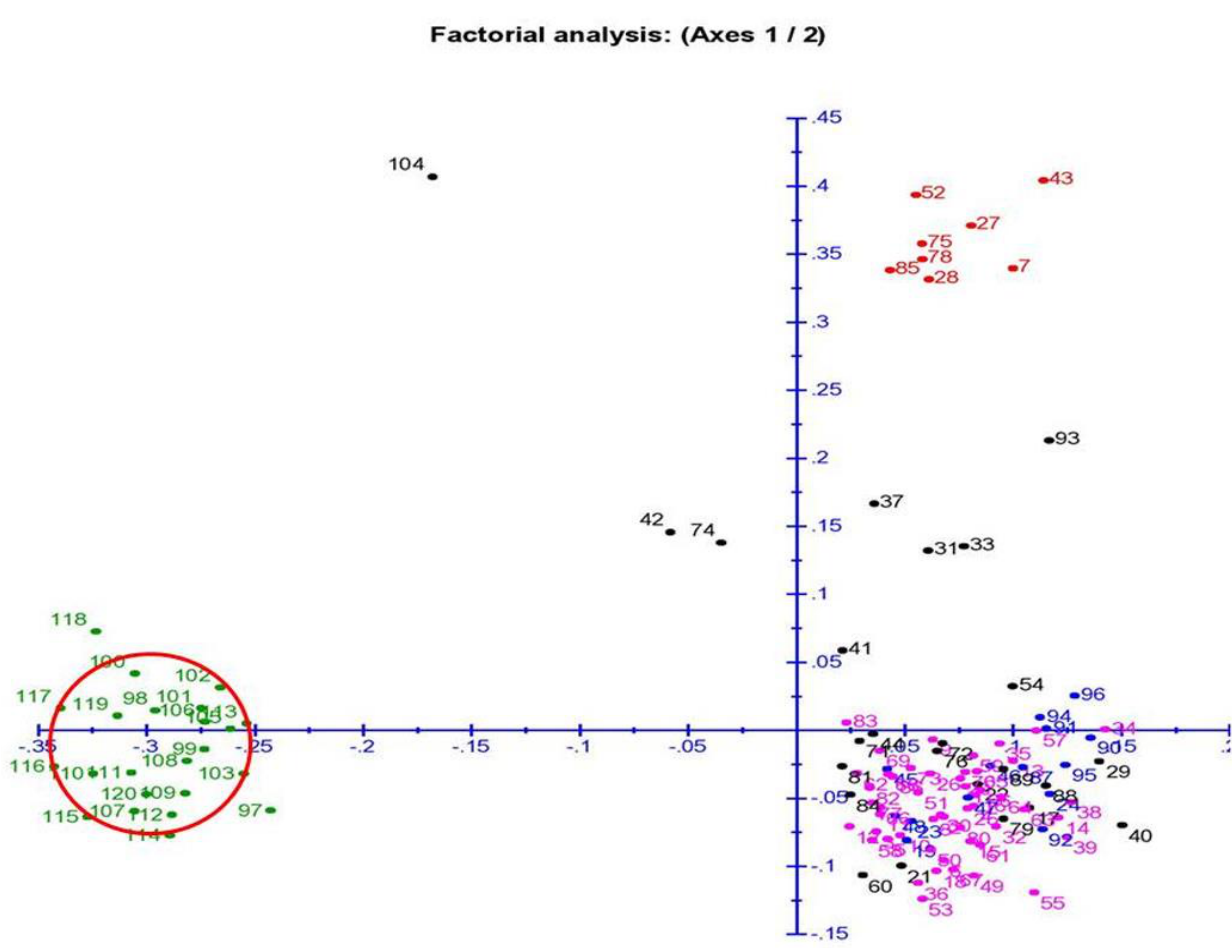
Figure 7. Principal coordinate analysis (PCoA) of 120 genotypes in the panel population for the 6 antioxidant traits using 136 molecular markers. The dot numbers in the figure represent the serial number of the genotypes enlisted in the Table 1. The numbers are colored on the basis of sub-populations obtained from structure analysis (SP1: Pink; SP2; Blue; SP3: Red; SP4: Green, and Admix: Black).